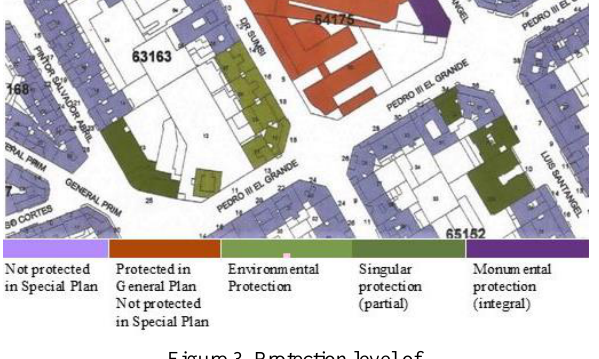
Figure 3. Protection level of the building complex.